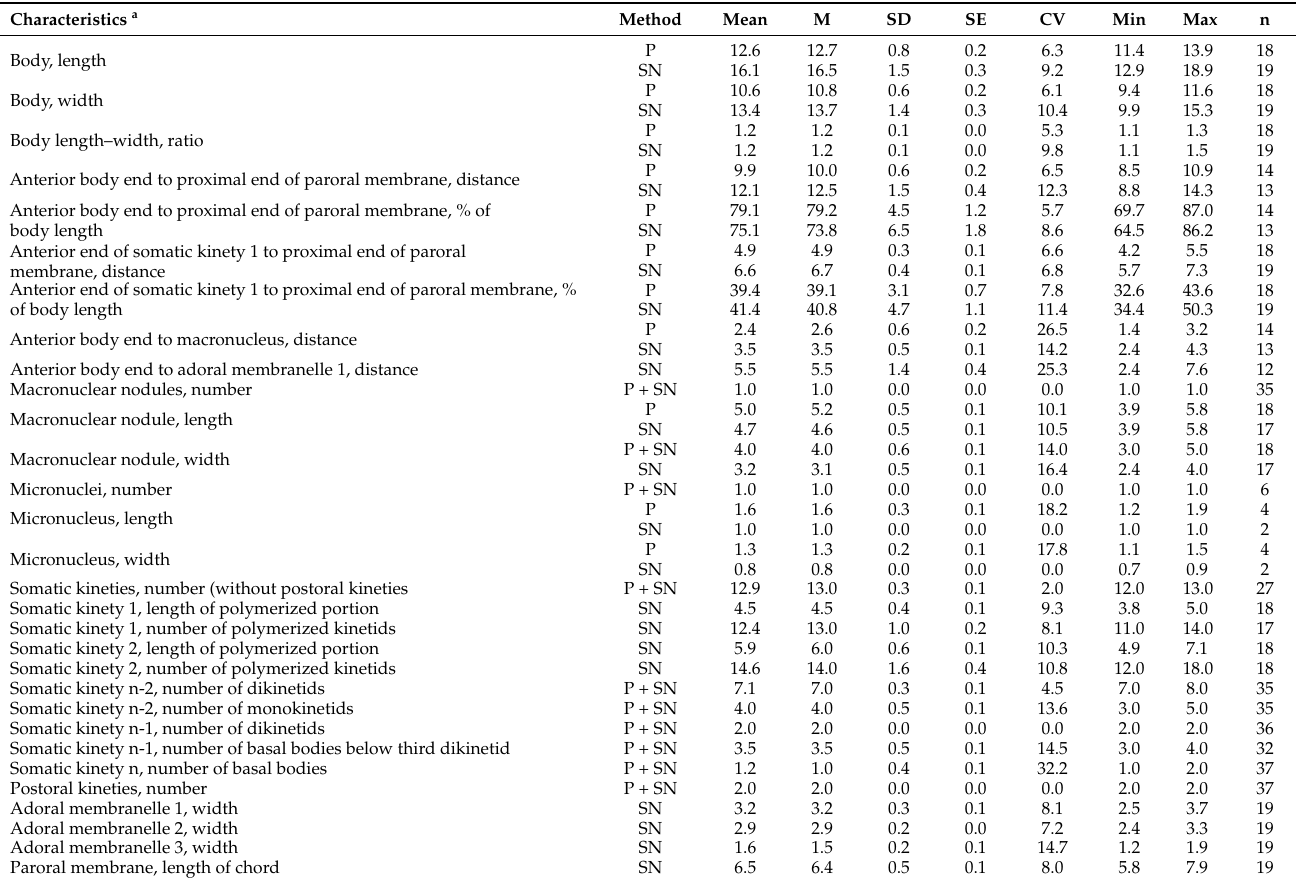
Table 1. Morphometric data on Cinetochilides minimus sp.